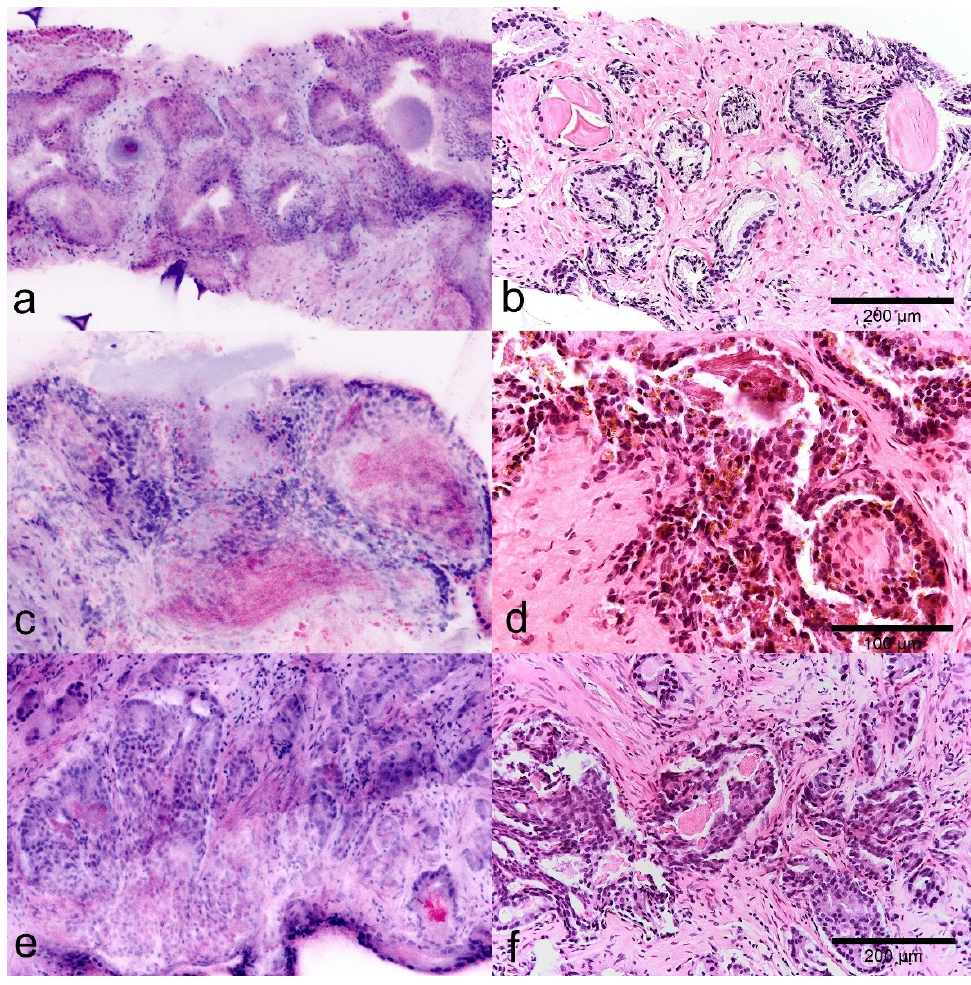
Figure 2. Diagnostic use of glandular secretions in FCM images (left) and FFPE slides (right). ( a , b ) Normal prostatic tissue with typical glands. Note the Corpora amylacea in the lumina of the organoid glands. ( c , d ) Parenchyma of the seminal vesicle. Diagnostic pigment is represented as intraepithelial granular material in the reflected light (red). ( e , f ) Atypical crystalloid secretions in the lumina of tumorous glands are detected as granular material in the lumina in reflected mode (red).